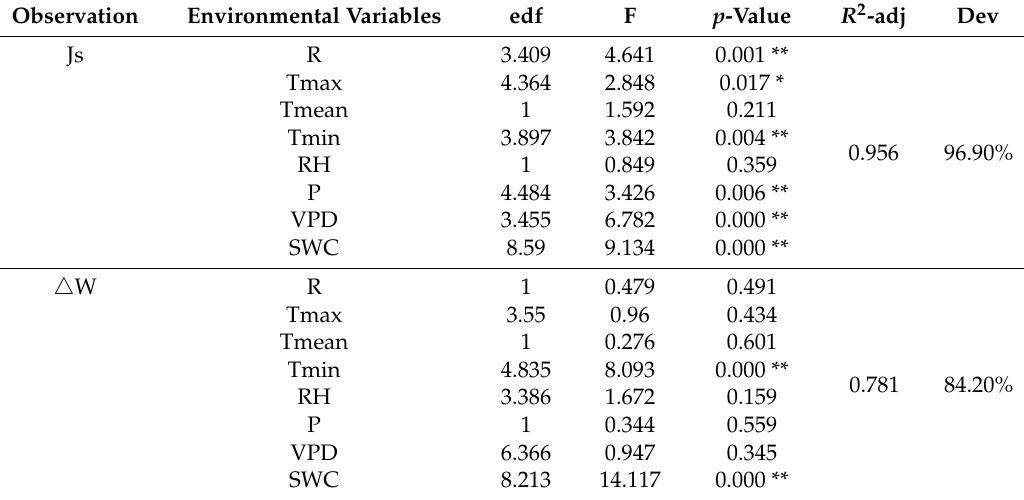
Table 3. GAM results of tests for the relationships between Js and (cid:52) W, and combined environmental variables.